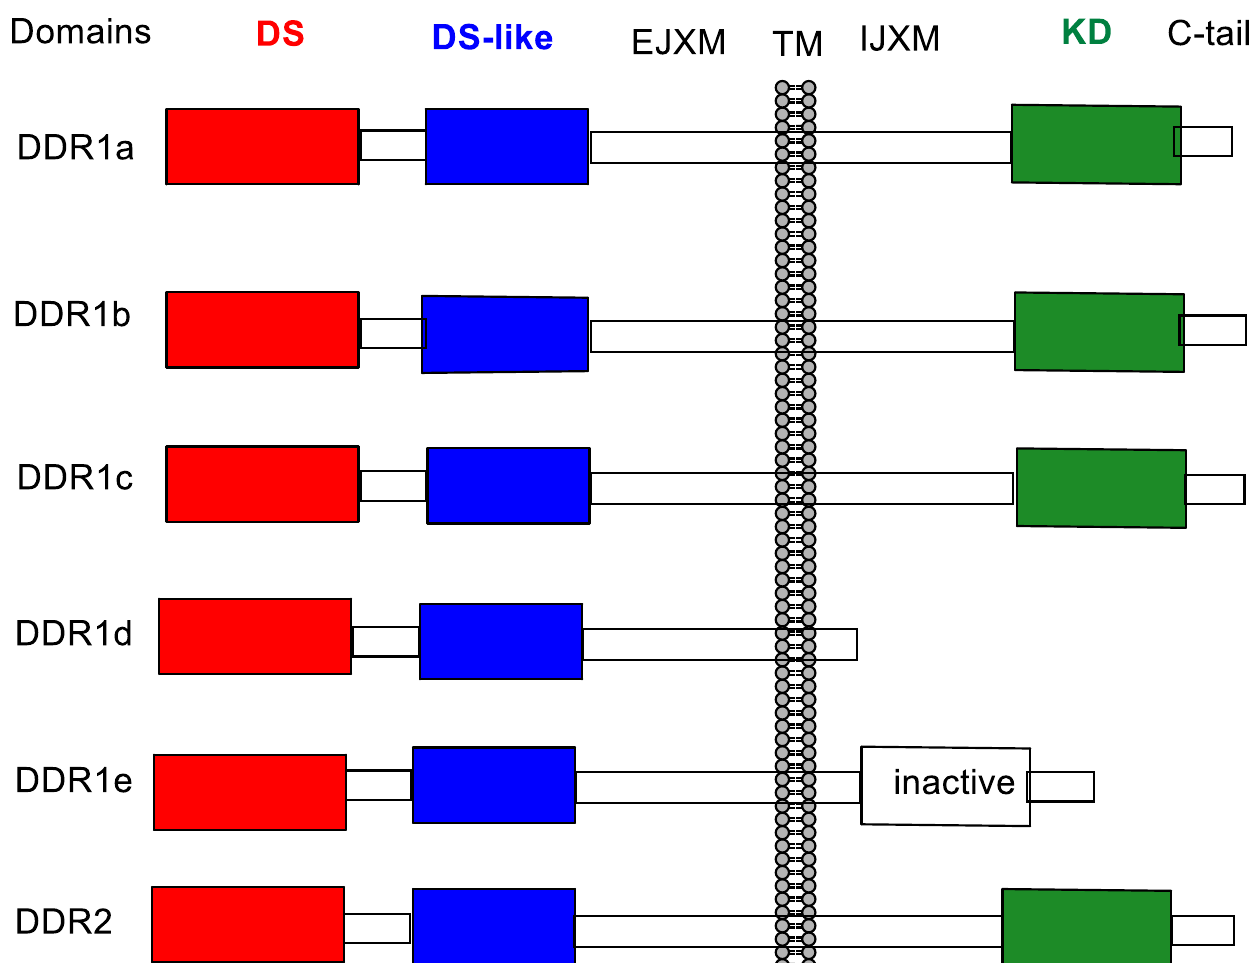
Figure 1. Generic structures of DDR1 and DDR2. DS, N-terminal discoidin domain; DS-like, discoidin-like domain [3]; EJXM, extracellular juxtamembrane domain; TM, trans-membrane domain; IJXM, intracellular juxtamembrane domain; KD, kinase domain. After [10].